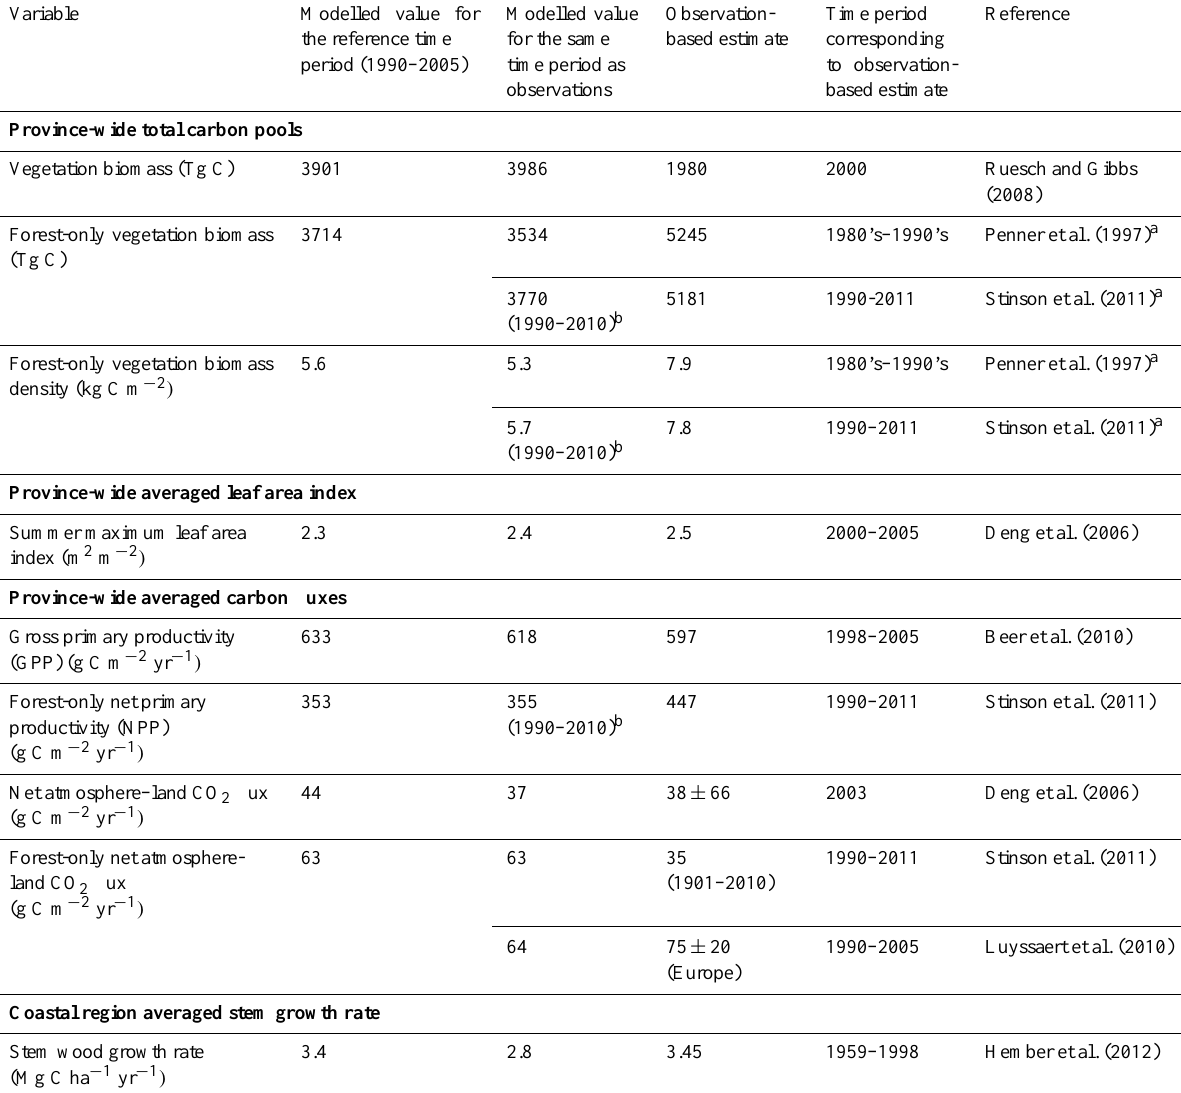
Table 2. Comparison of simulated vegetation biomass, leaf area index, gross primary productivity, net atmosphere–land CO 2 flux and stem wood growth rates with observation-based estimates for the province of British Columbia, Canada, from the CLIM + CO 2 simulation with the modified PFT set. Modelled results are reported for the 1990–2005 reference period but also for the time period that corresponds to each observation-based